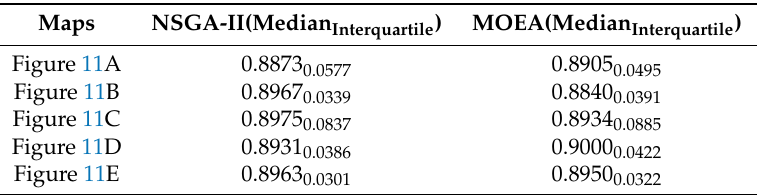
Table 2. Hypervolume results of NSGA-II and MOEA.